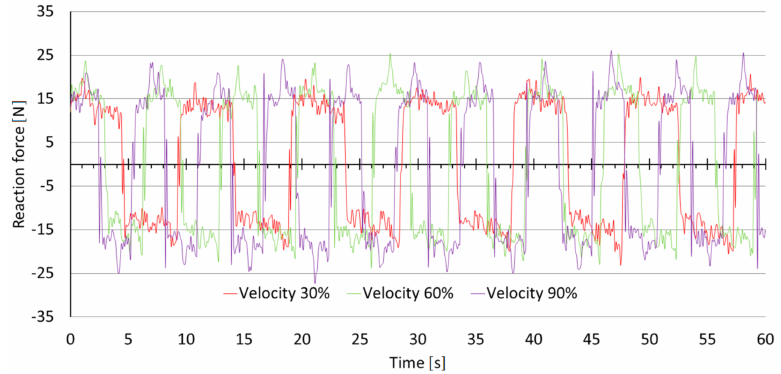
Figure 6. Reaction forces acting on the driving mechanism during operation of empty conveyor; the material shifting speeds are adjusted at the levels of 30%, 60% and